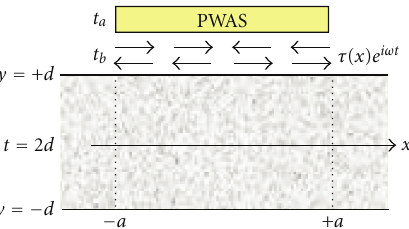
Figure 1: PWAS and structure interaction through the interface